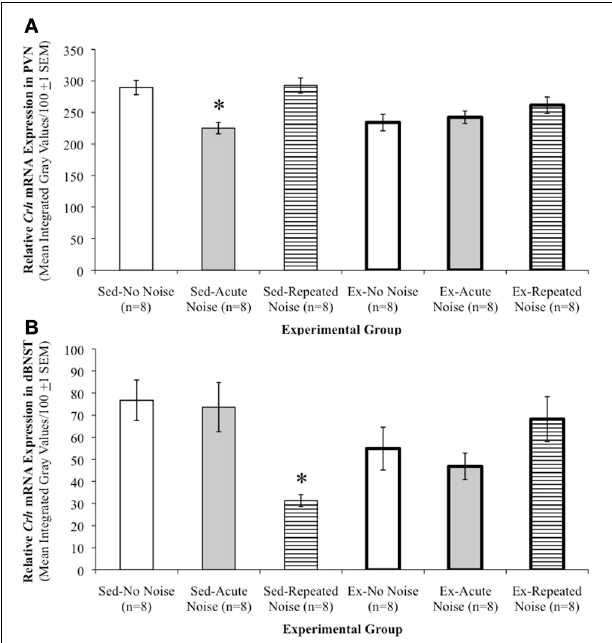
FIGURE 3 | Stress-induced Crh regulation in the PVN and dBNST is different in exercised compared to sedentary rats. (A) Relative Crh mRNA expression levels in the paraventricular nucleus of the hypothalamus (PVN). Significant main effects of Activity Status and Stress Treatment were observed, with reliably lower PVN- Crh mRNA expression levels in Ex as compared to Sed rats, and significantly greater expression levels in Repeated as compared to Acute Noise groups, although neither of these two groups differed reliably from the No Noise controls. The interaction effect was also significant, such that, while acute and repeated noise stress exposure had little effect on Crh mRNA expression in the PVN of Ex rats, the Sed rats acutely exposed to noise showed a reliable reduction in mRNA expression as compared to the other two Sed groups, which did not differ. Group means are mean integrated gray values/100 ( ± 1 s.e.m.), presented as arbitrary units.